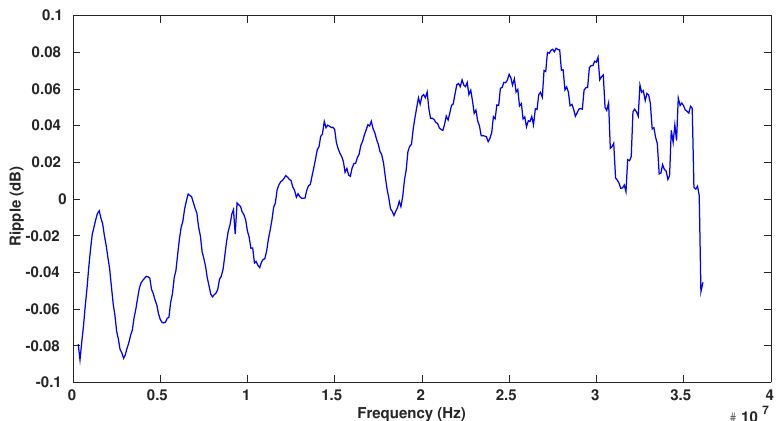
Figure 12. Frequency response of the decimation filter for an OSR of